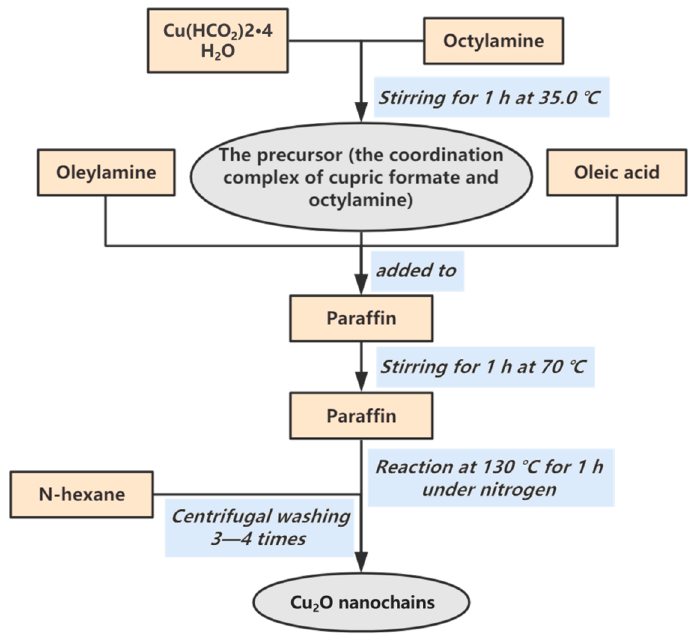
Figure 2. Synthesis process flow chart of Cu 2 O nanochains.